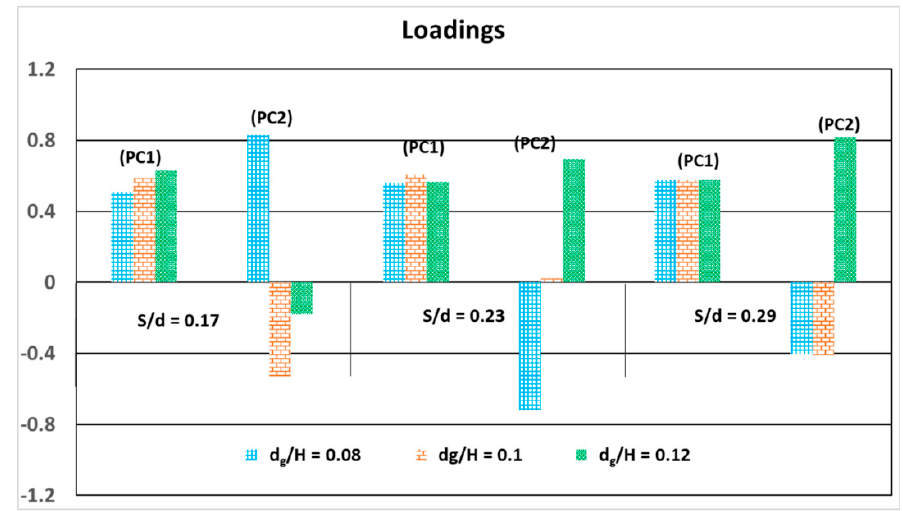
Figure 13. Principal component loadings for the first and second component (PC1 and PC2).